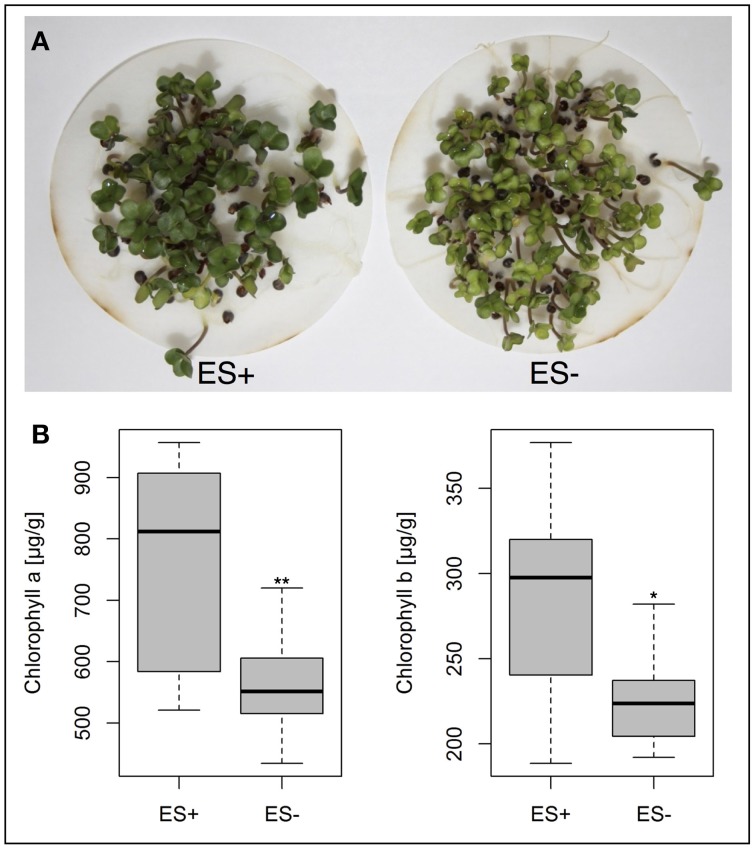
(A) Phenotypic variation for cotyledon chlorophyll pigmentation in B. napus genotypes showing high (ES+) and low (ES−) elongation radicle rates. (B) Box plots representing chlorophyll a and chlorophyll b concentrations of 10 genotypes each, showing high and low elongation radicle rates. Significant differences were calculated with student's t-test at p < 0.05* and p < 0.01**.